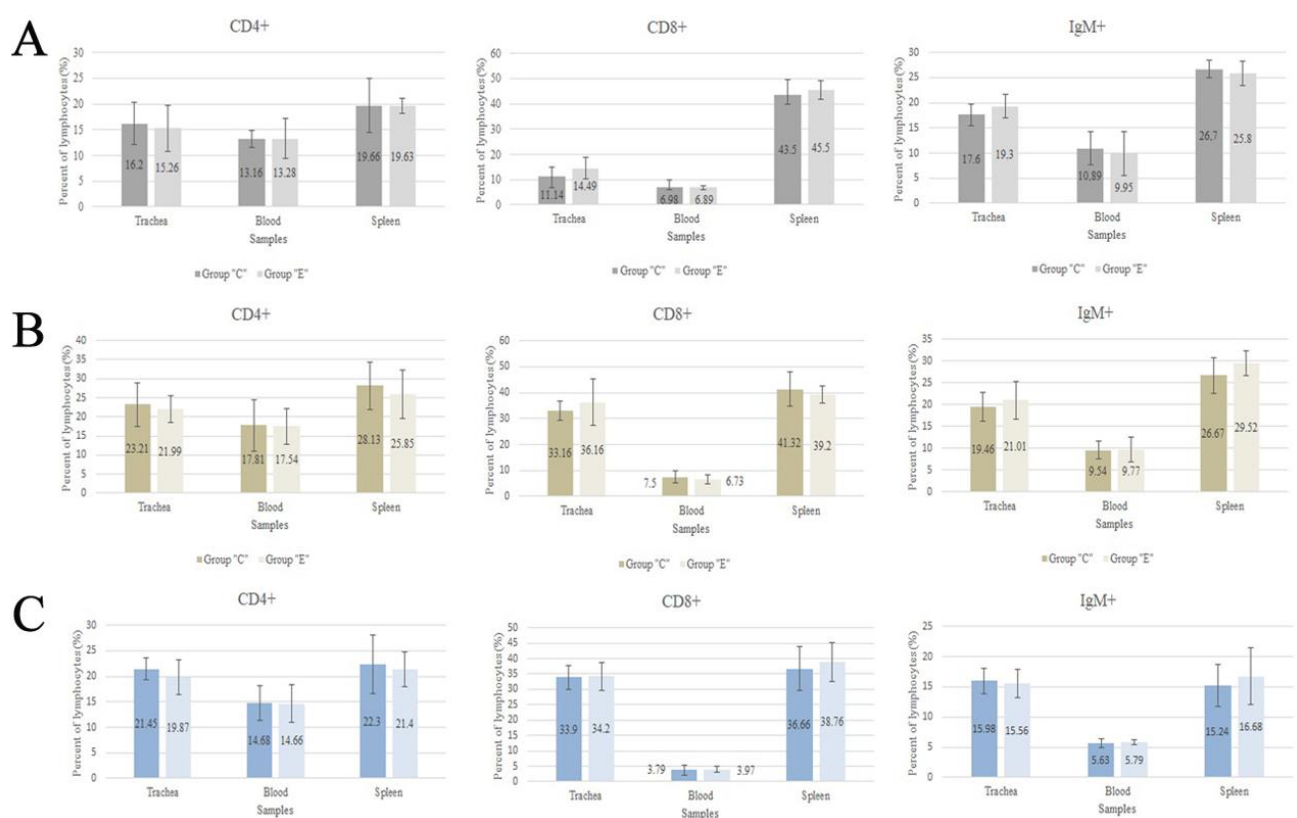
Figure 2. Percentages of T (CD4+ and CD8+) and B (IgM+) cell subpopulations in trachea, blood, and spleen samples in control (group “C”) and experimental group (group “E”) of parent-stock chickens ( A ), broiler chickens ( B ) and turkeys ( C ).